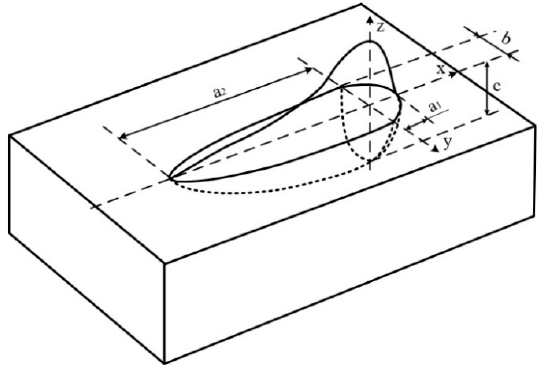
Figure 3. Double-ellipsoid heat source model.